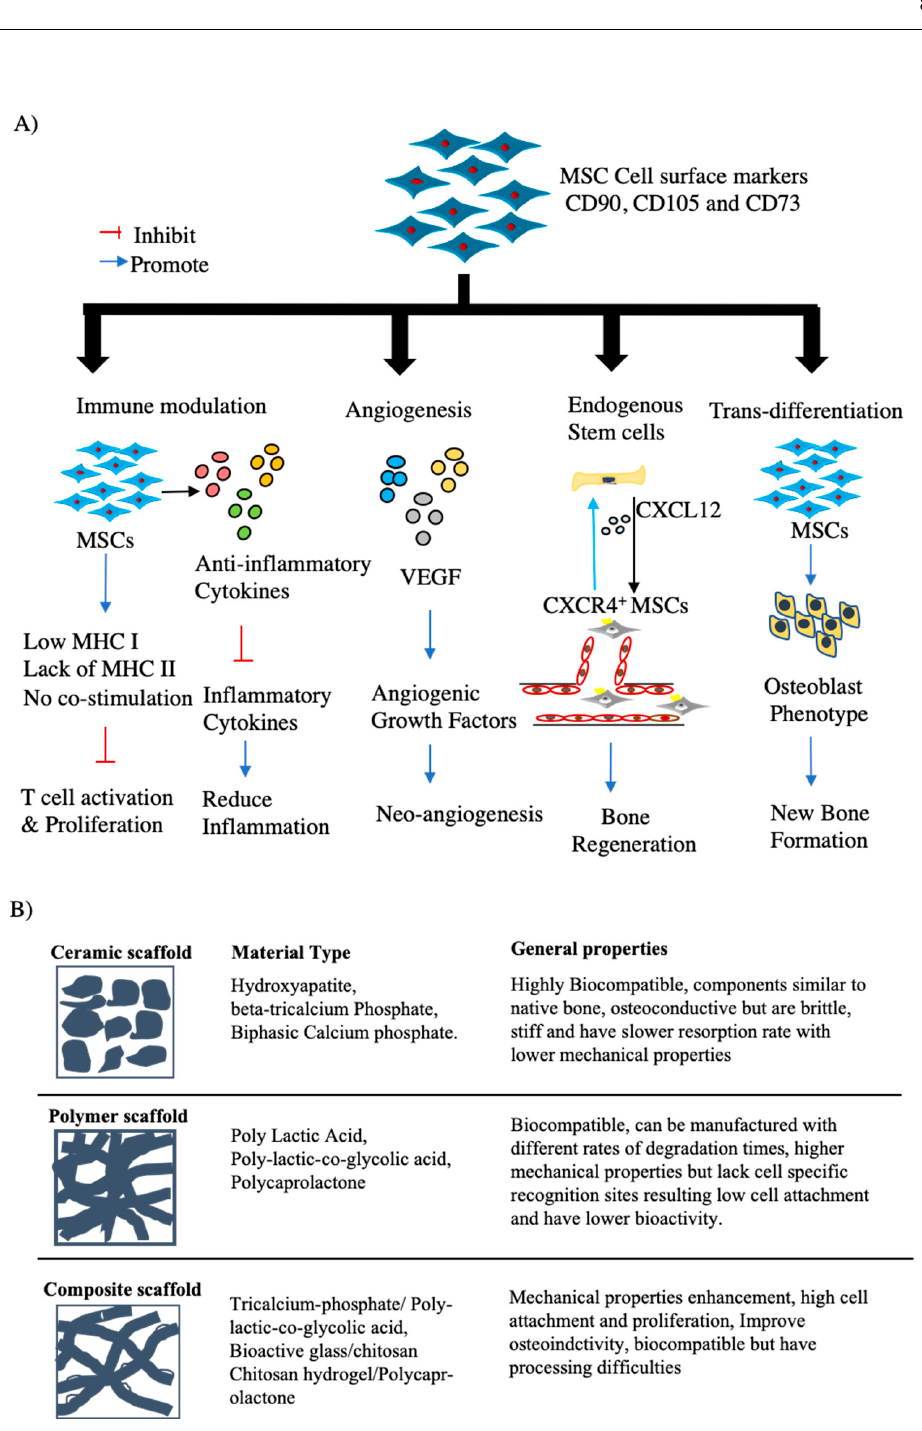
Figure 2. The combination of MSCs and bioscaffold materials used for BTE. ( A ) Mechanisms underlying MSC-based bone regeneration. Due to their characteristic expression of cell markers CD90, CD105, and CD73, and lack of HLA-molecules, MSCs have a bone tissue regeneration capacity through the actions of several mechanisms, including (1) the modulation of immune responses through the prevention of T-cell activation and reduction in the secretion of inflammatory cytokines; (2) the secretion of the angiogenic induction factor VEGF, which helps to form new blood vessels and in turn enhance bone regeneration; (3) the release of chemotactic chemokines at the bone defect site to recruit endogenous stem cells that will further enhance bone regeneration at that location; (4) the trans-differentiation of these cells into osteoblasts under the influence of host-derived factors that helps to promote new bone formation. ( B ) Representation of the routinely used scaffolds with examples and their general properties in the development of BTE technology.